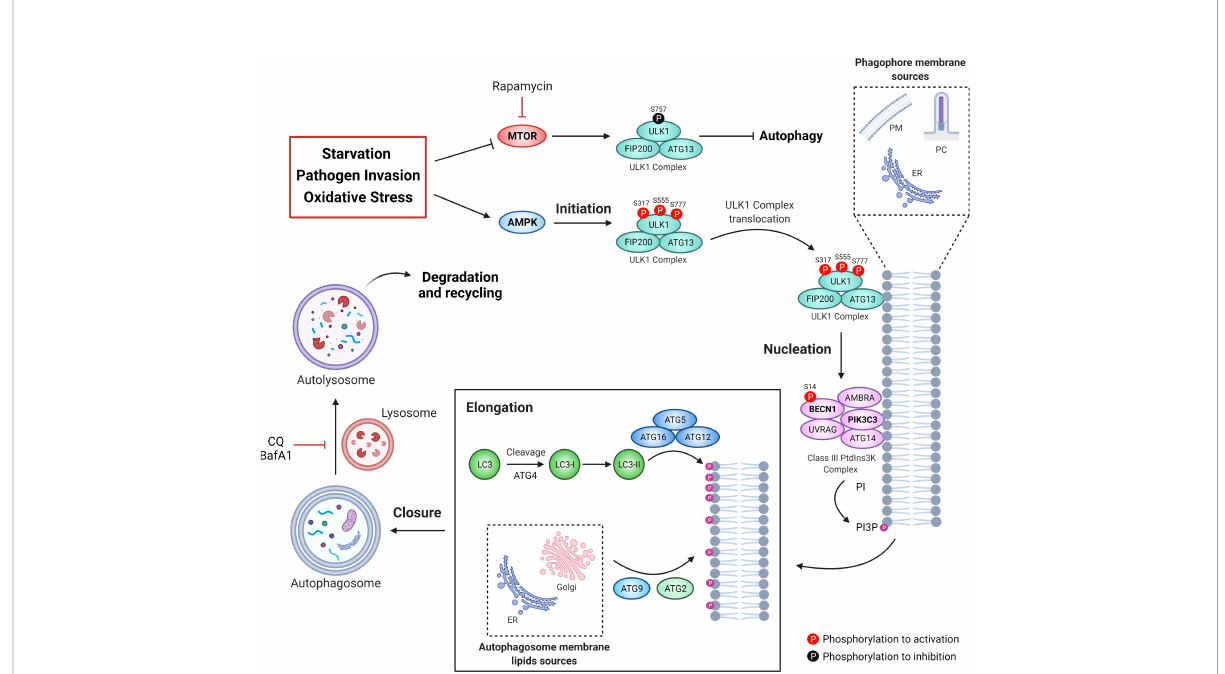
FIGURE 2 The autophagic machinery. Different types of stressors can be sensed by MTOR and AMPK. MTOR inhibits the ULK1 complex kinase activity phosphorylating its Ser757. Under stress conditions, AMPK activates ULK1 by phosphorylation on Ser317, Ser555, and Ser777, leading to the activation of the class III phosphatidylinositol 3-phosphate kinase complex (PtdIns3KC3). Then, active PtdIns3KC3 increases the levels of phosphatidylinositol 3-phosphate (PtdIns3P) in speci fi c membrane micro domains, allowing the recruitment of proteins like the WD repeat domain, phosphoinositide interacting (WIPI). Thus, elongation of the phagophore membrane is mediated by two ubiquitination-like systems: the complex ATG12-ATG5-ATG16 and the conjugate LC3-phosphatidylethanolamine (PE), known as LC3-II. Additionally, both ATG2 and ATG9 participate in the elongation of the autophagosome through the traf fi cking of lipids from the endoplasmic reticulum or the Golgi apparatus. Once that the autophagosome membrane engulf intracellular components it encloses itself and then fuses with lysosomes to form the autolysosome. Chloroquine (CQ) or ba fi lomycin A1 (BafA1) can be used to block autophagosome-to-lysosome fusion, allowing the accumulation of